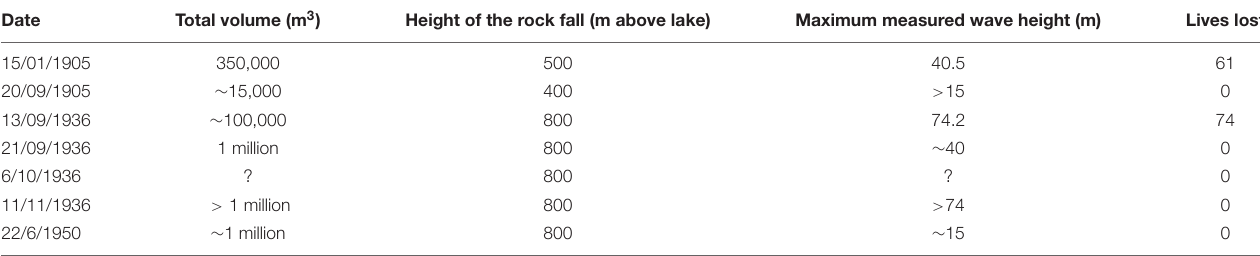
TABLE 1 | List of historical rock fall events occurring in the Lovatnet Valley (Jørstad,